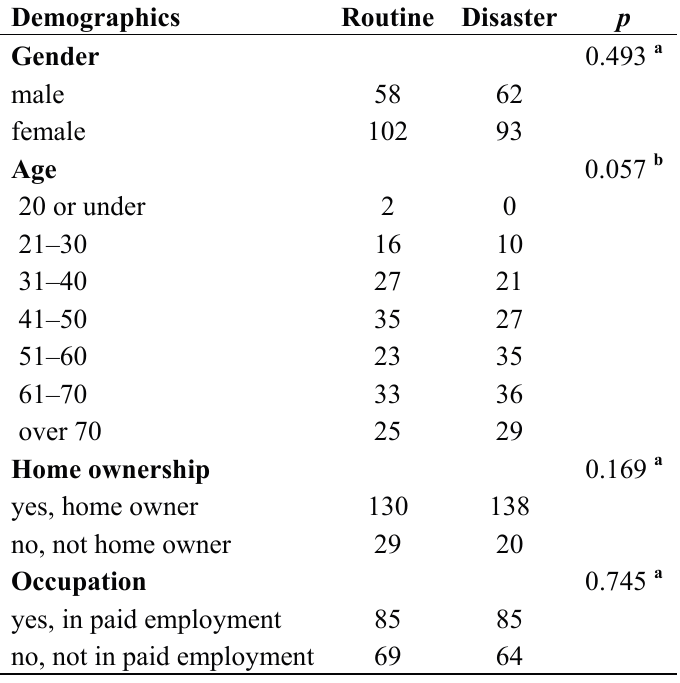
Table 1. Demographics of routine incident and natural disaster